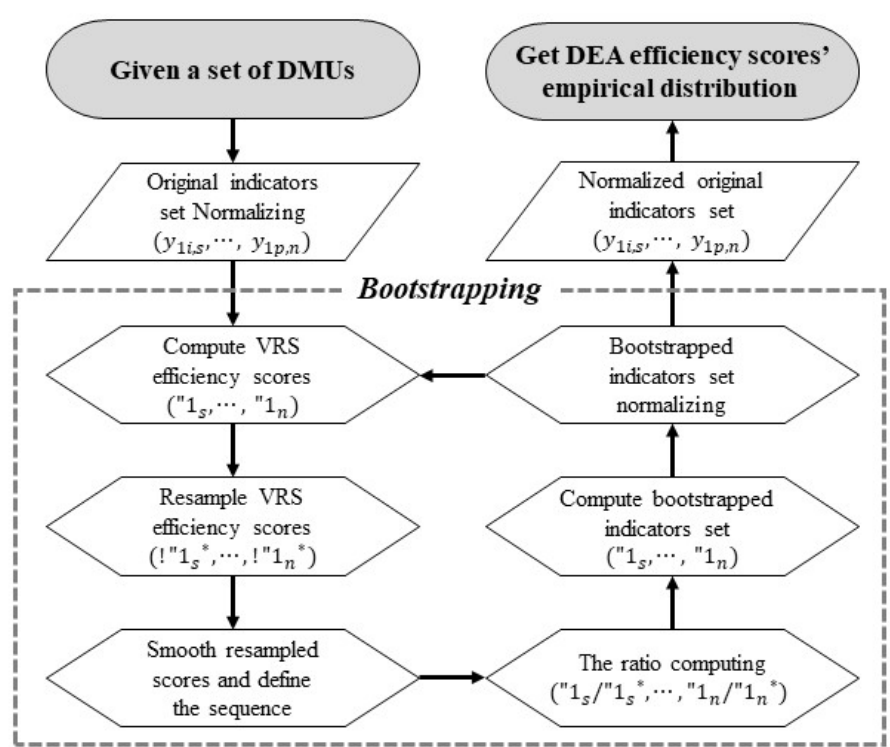
Figure 4. Bootstrap procedure based on [58–60].